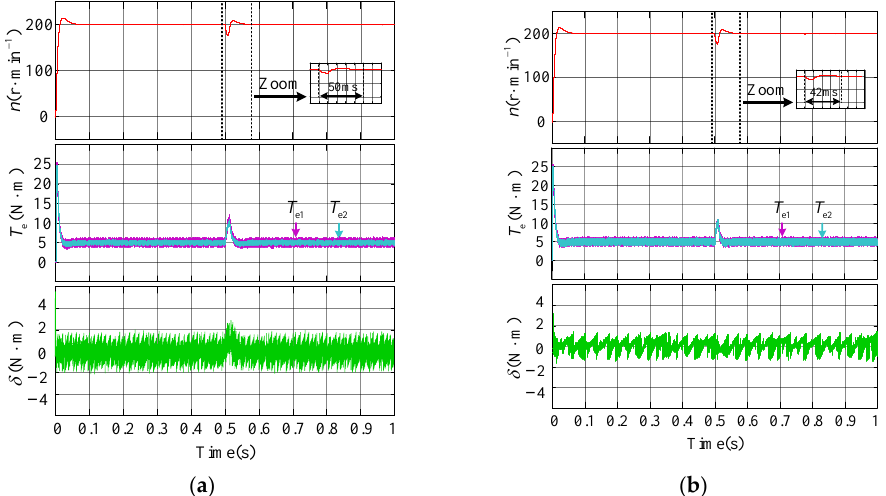
Figure 8. Simulation results for load torque disturbance: ( a ) the closed-loop control strategy and ( b ) the proposed FCS- MPC